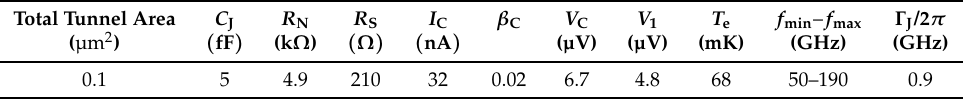
Table 2. Summary of measurement values of R N , R S , I C and f min,max ≡ V min,max / Φ 0 at T ≈ 15mK and also estimations of SQUID parameters C J , β C , V C , V 1 , T e and Γ J . Values V 1 and T e are estimated at V JJ = 300 µV ( f J ≈ 145GHz).